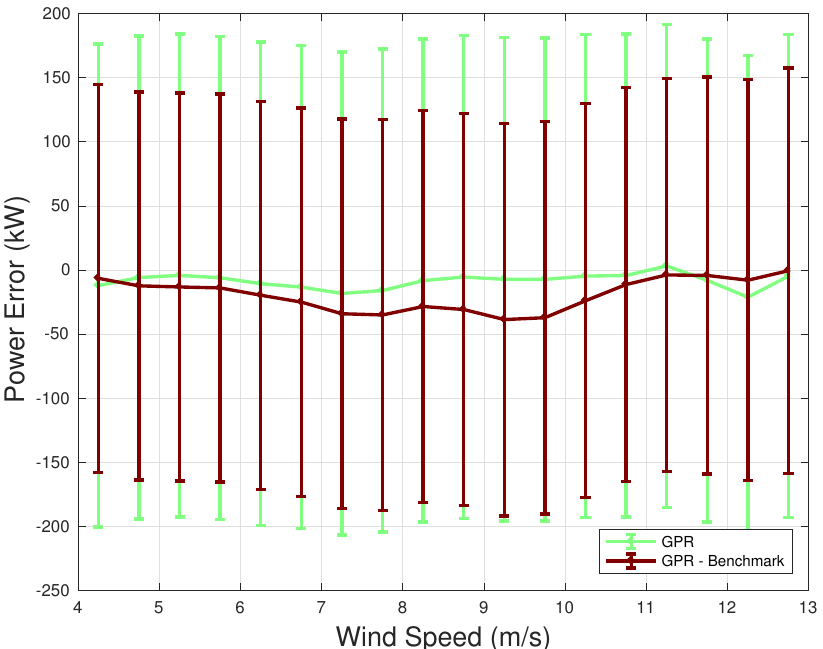
Figure 6. Average error between model predictions and model estimate: GPR and GPR